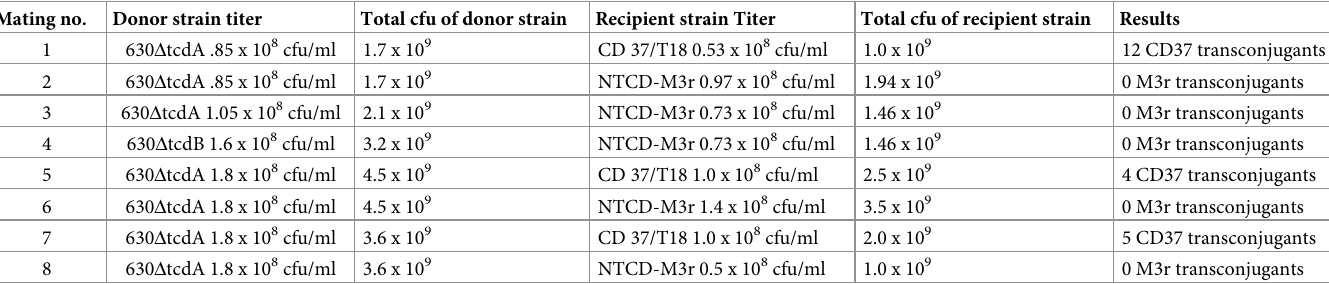
Table 3. Filter matings between toxigenic strain 630 Δ tcd A and 630 Δ tcd B and nontoxigenic strains CD37/T18 and NTCD-M3r. Mating